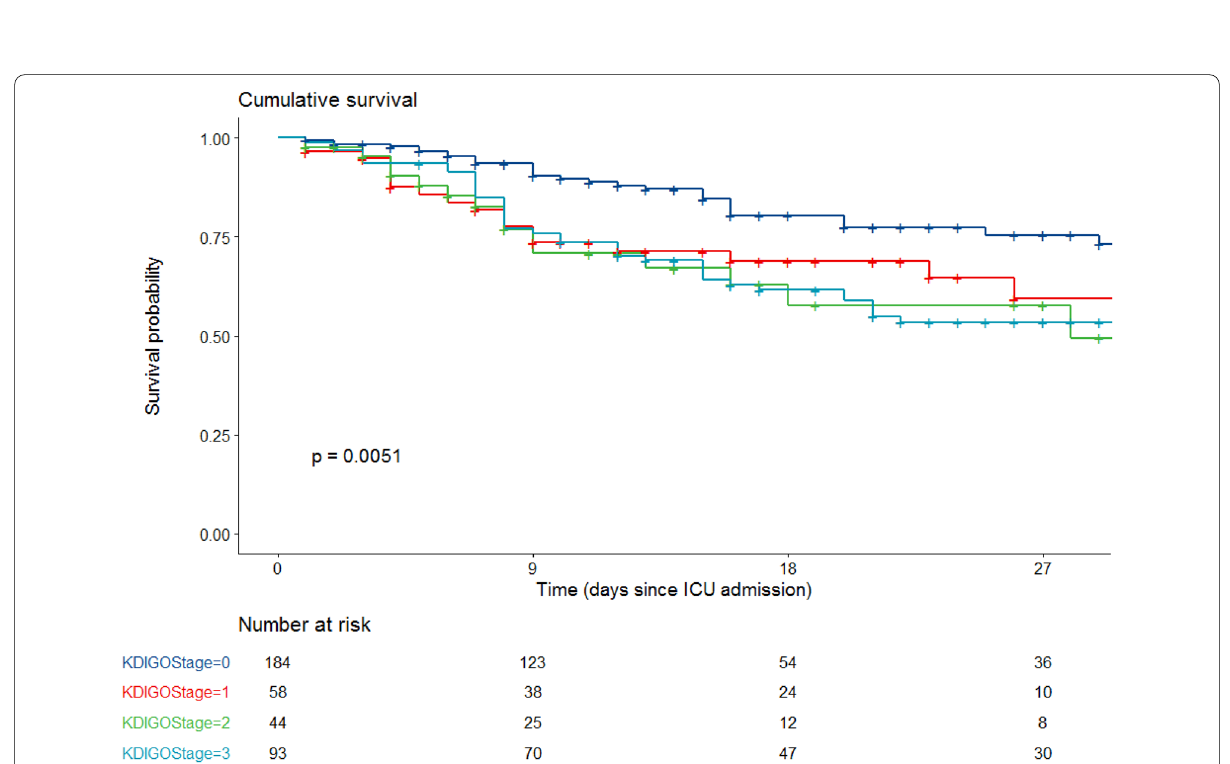
Fig. 3 Univariate Kaplan–Meier curves according to KDIGO stages of acute kidney